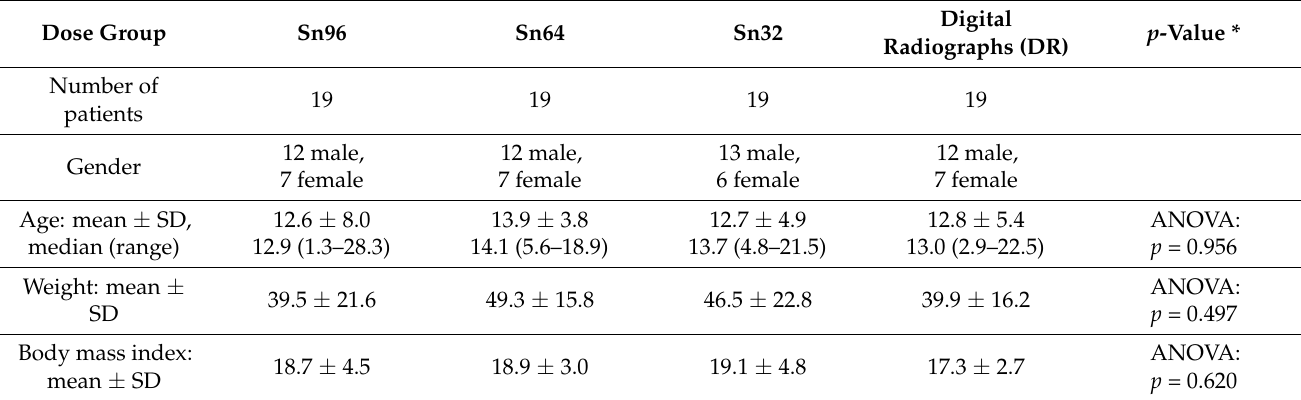
Table 1. Patient